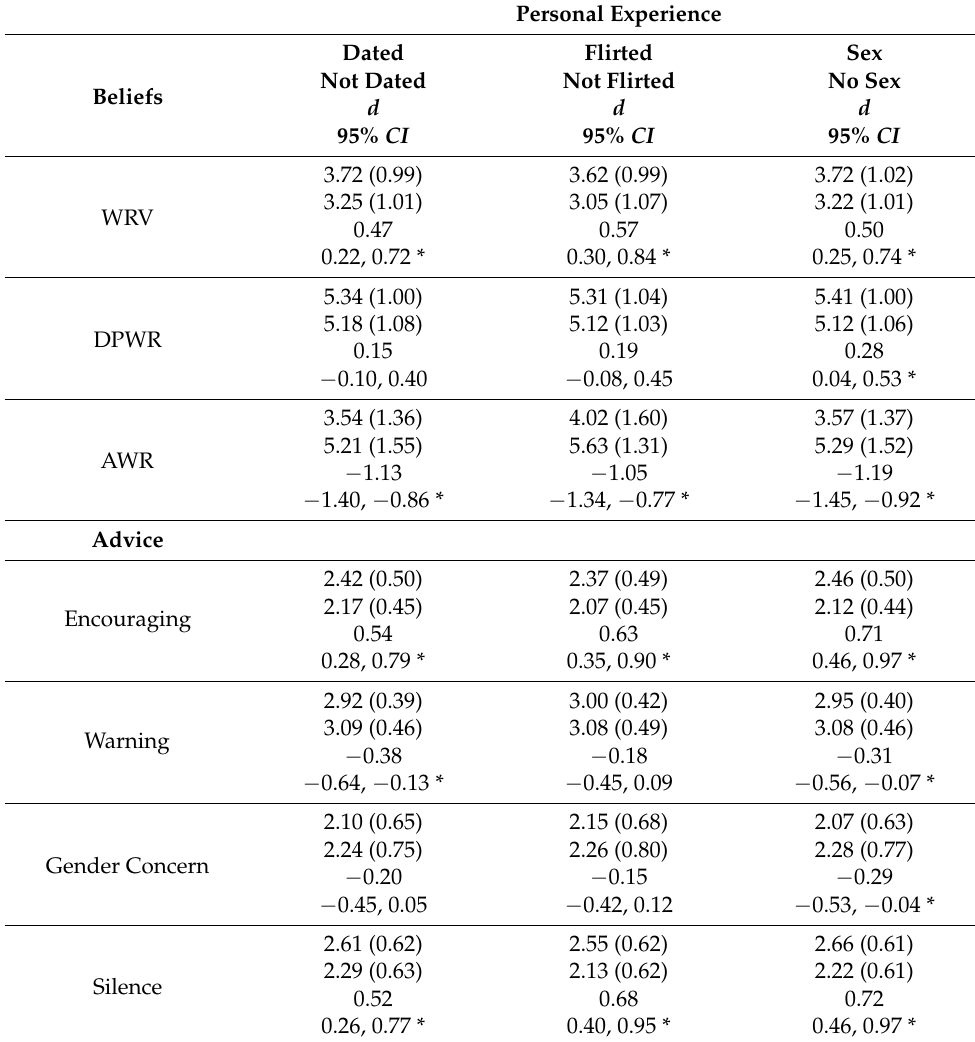
Table 4. Difference in workplace romance beliefs and advice based on personal experience. Personal Experience